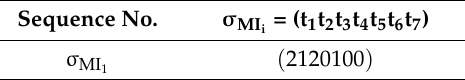
Table 11. Forbidden sequences of Example 3.